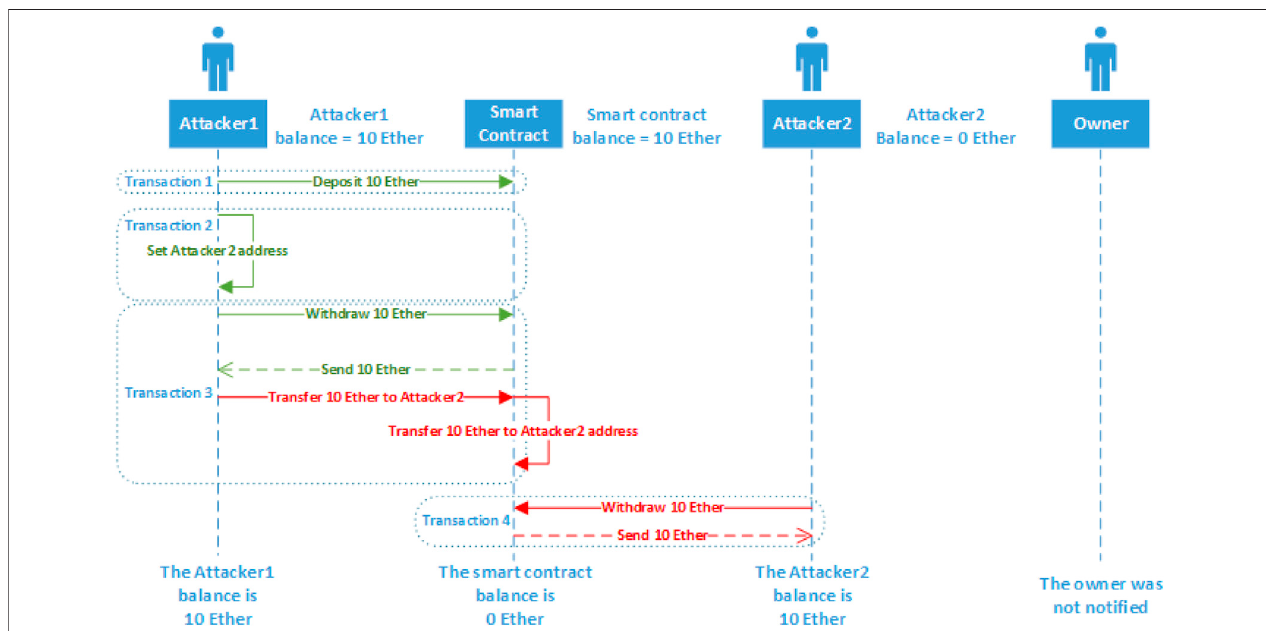
FIGURE 11 | UML sequence diagram for the fi rst scenario in the second case